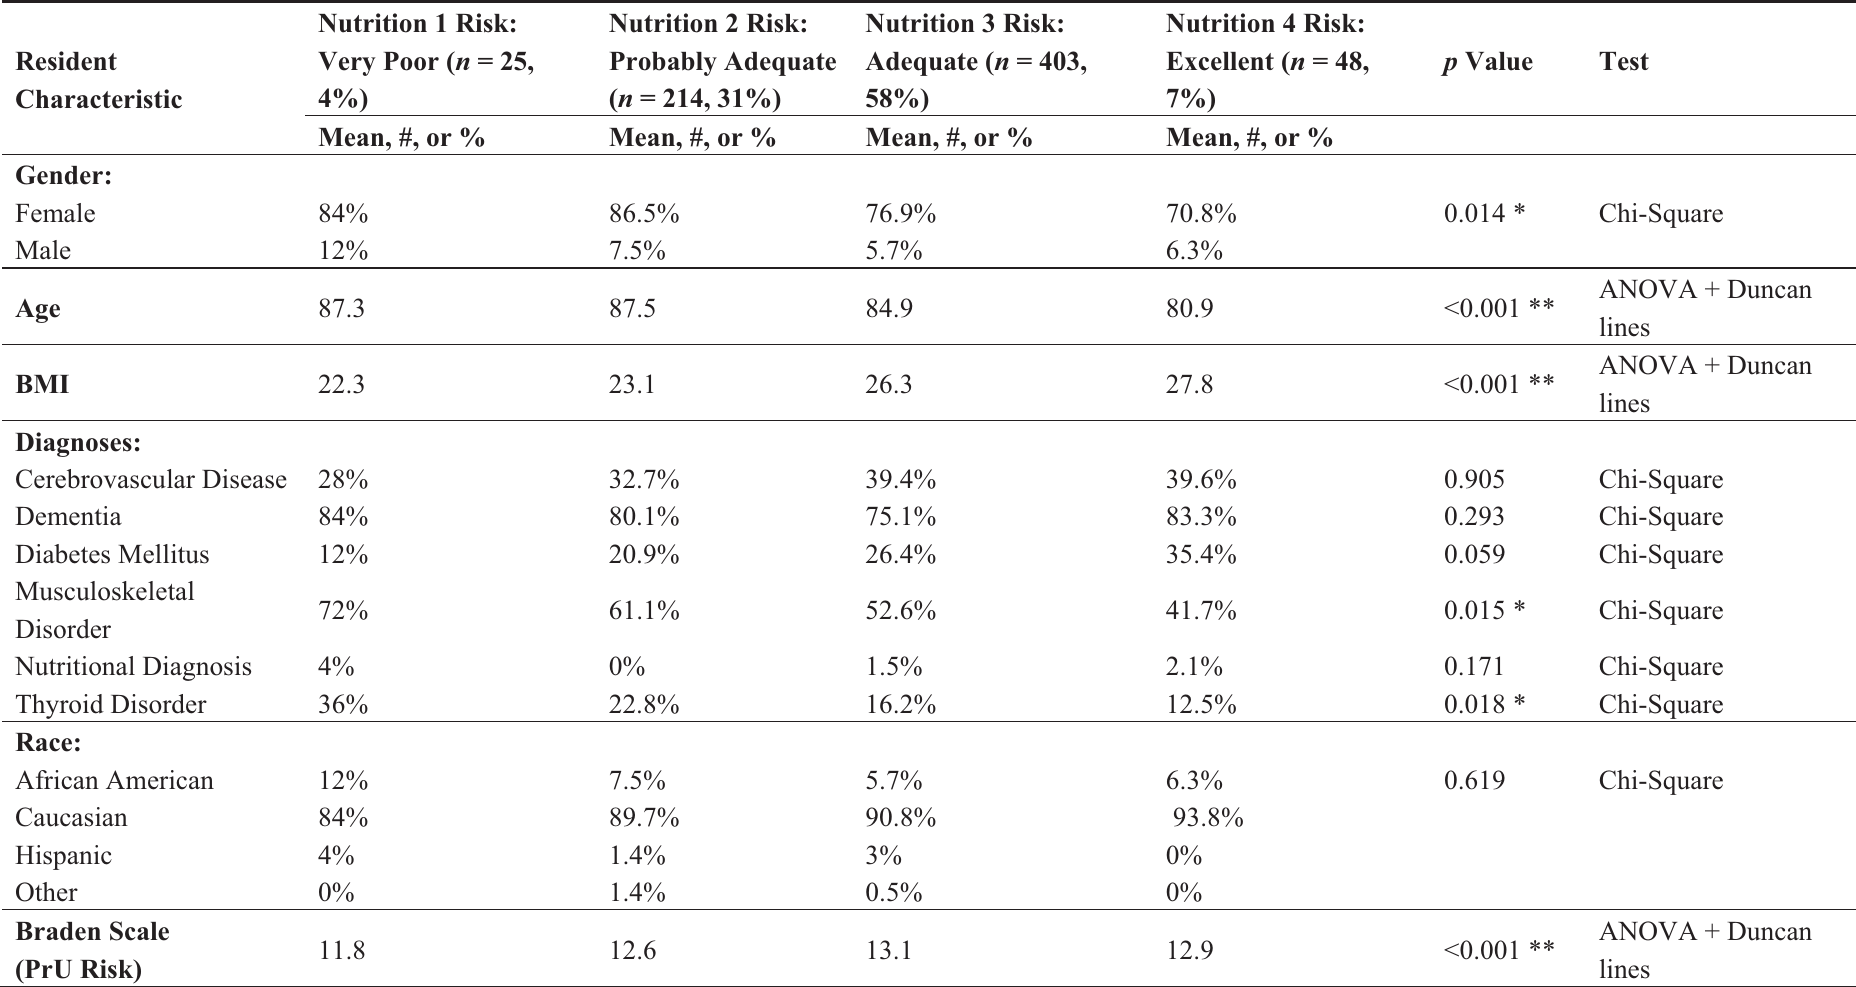
Table 1. Resident Participant Characteristics Gender, Age, BMI, Diagnoses, and Braden Scale Score Grouped According to Braden Nutrition Subscale Risk Categories ( n =